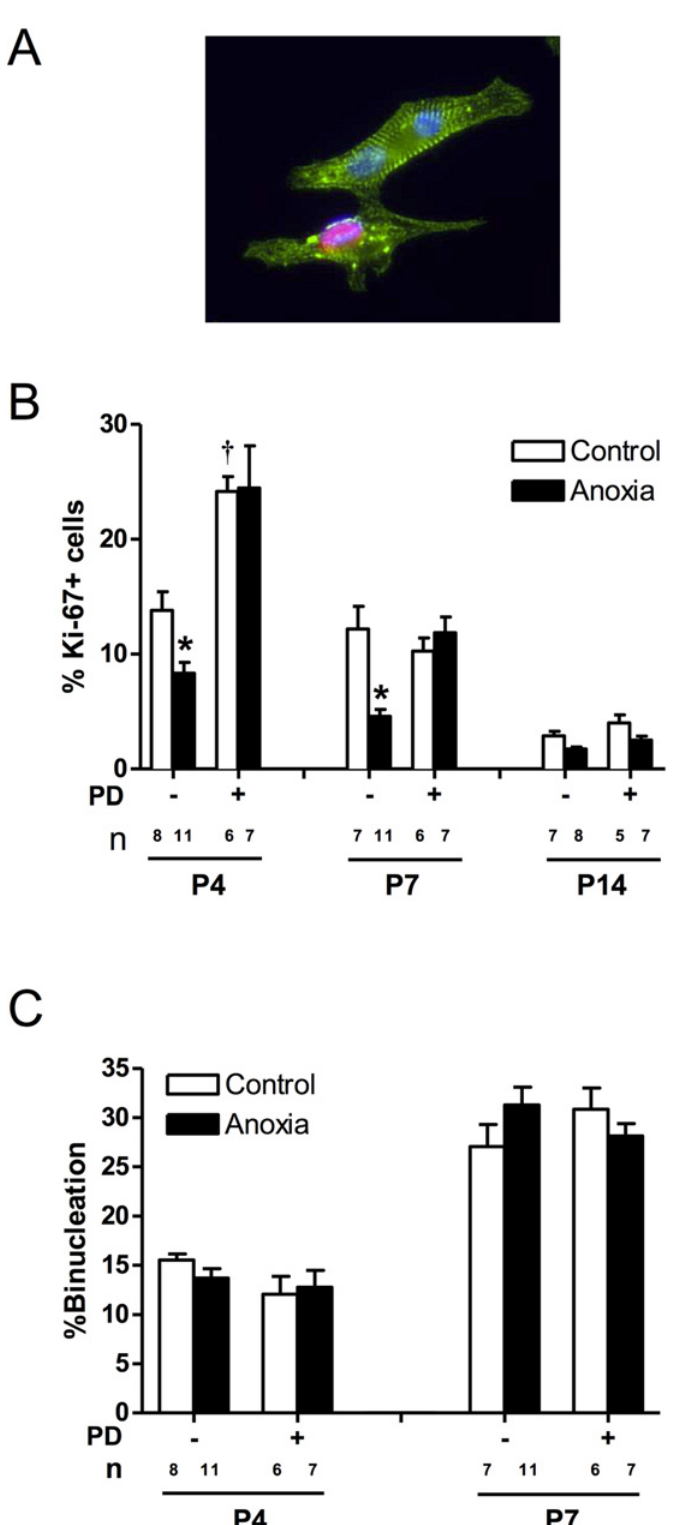
Fig 3. Effect of newborn anoxia and PD156707 on proliferation and binucleation of neonatal cardiomyocytes. Cardiomyocytes were isolated from P4, P7, and P14 neonatal rats that were treated